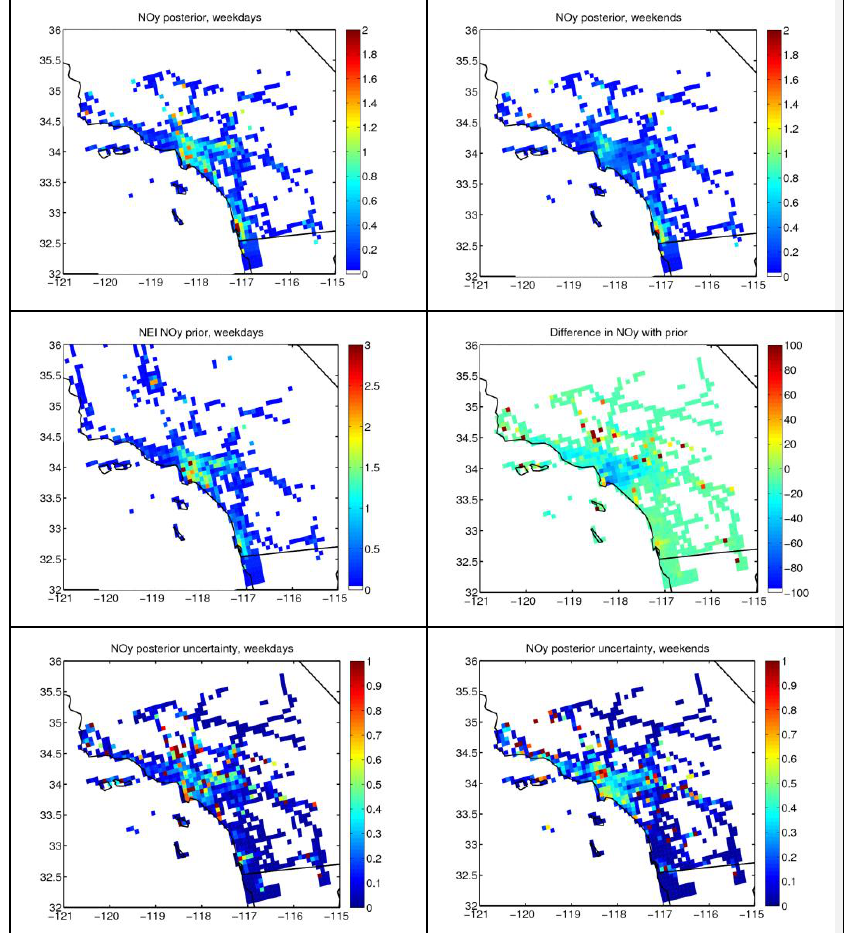
Fig. 4. Same as Fig. 3, but for NO y